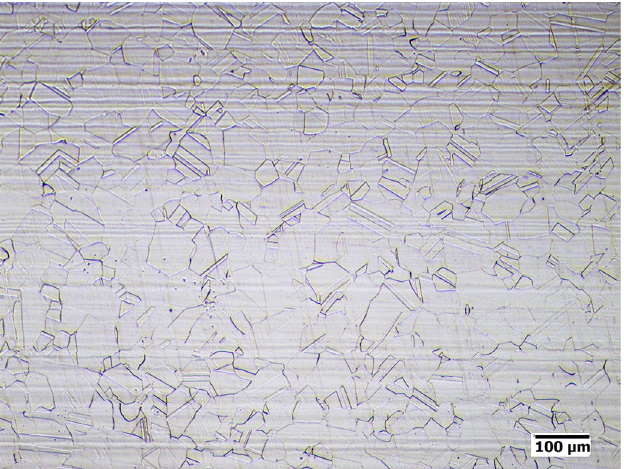
Figure 1. AISI 904L specimen prior to cold rolling process (starting material).